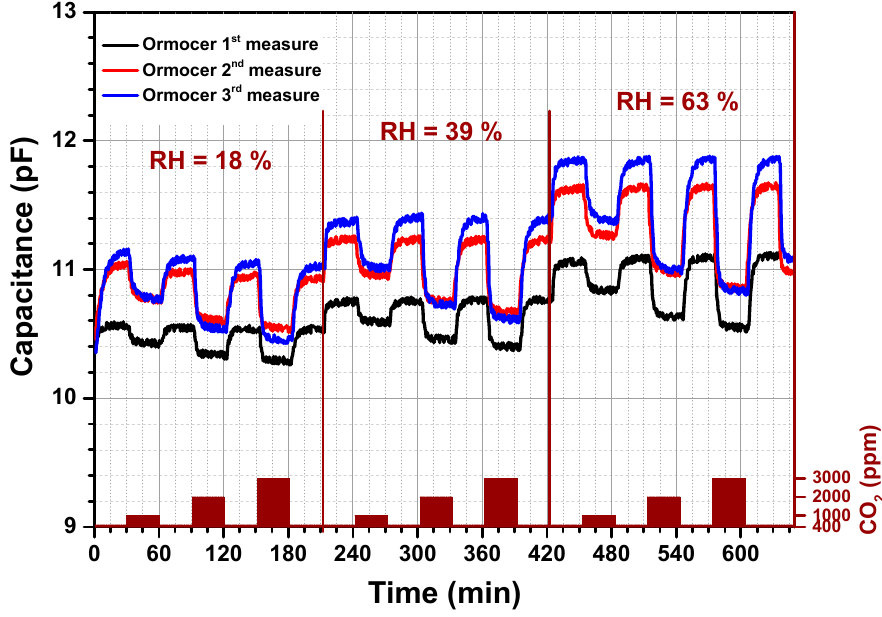
Figure 1. Capacitance response versus time of Ormocer based CO 2 sensor. Capacitance change recorded under different CO 2 concentrations and relative humidity